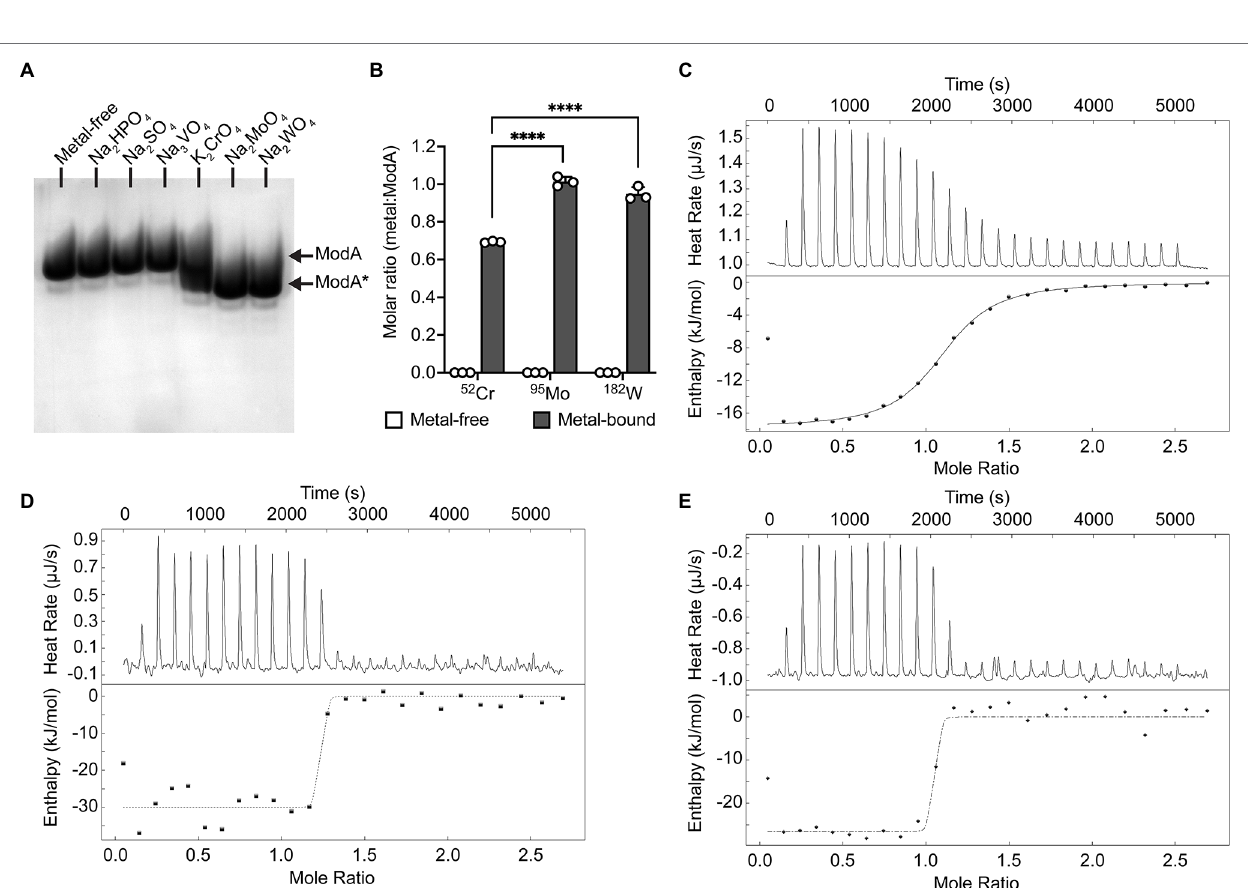
FIGURE 1 | Biochemical characterization of Pseudomonas aeruginosa ModA. (A) Ligand-dependent protein mobility shift gel electrophoresis was performed under native PAGE conditions. Recombinant P. aeruginosa PAO1 ModA was incubated with 10-fold molar excess of Na 2 HPO 4 , Na 2 SO 4 , Na 3 VO 4 , K 2 CrO 4 , Na 2 MoO 4 , and Na 2 WO 4 . Ligand-free (ModA) and ligand-bound (ModA*) states are indicated by arrows. (B) ICP-MS analysis of recombinant ModA incubated with 10-fold molar excess of Na 2 MoO 4 , Na 2 WO 4 , and K 2 CrO 4 . Metal content is expressed as molar ratio of metal to ModA. Data represent the mean (±SEM) of three independent biological experiments. Statistical significance of the differences was determined by two-way ANOVA with Sidak post-test, **** = p < 0.0001. (C–E) Isothermal titration calorimetry (ITC) curves of 40 μ M ligand-free ModA titrated against 320 μ M of chromate (C) , molybdate (D) , or tungstate (E) oxyanion ligands. Raw titration data (top panel) and complete binding isotherms for ModA (bottom panel) are shown. The integrated curves, after correction for enthalpy changes and normalizing the oxyanion ligand concentrations, were best fit using the “independent” model and a single binding site for the ligands (line).